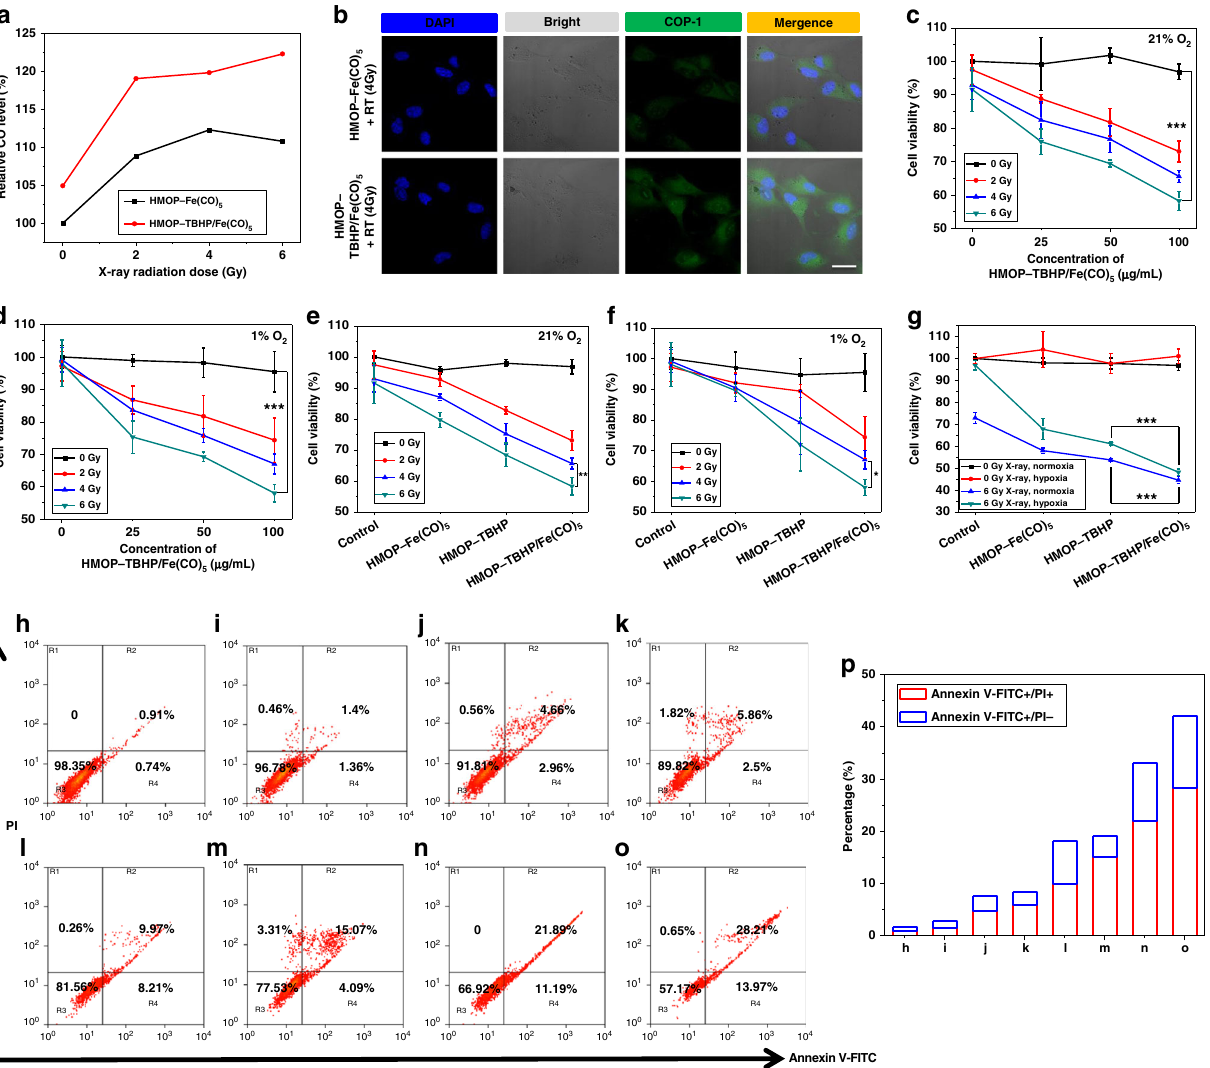
Fig. 7 In vitro evaluation of synergistic RDT/gas therapy. a Quantitative evaluation of CO generation in normoxic (21% O 2 ) U87MG cells after incubation with HMOP-Fe(CO) 5 or HMOP-TBHP/Fe(CO) 5 upon varied doses (0, 2, 4, and 6 Gy) of X-ray irradiation. The intracellular CO was monitored using a fl uorogenic COP-1 probe. b Confocal fl uorescence imaging of normoxic (21% O 2 ) U87MG cells after incubation with HMOP-Fe(CO) 5 or HMOP-TBHP/Fe (CO) 5 upon 4 Gy of X-ray irradiation. Scale bar: 50 µ m. c , d Cell viabilities (by MTT assay) of U87MG cells subjected to varied doses (0, 2, 4, and 6 Gy) of X-ray irradiation with or without different concentrations of (0, 25, 50, 100 µ g mL − 1 ) HMOP-TBHP/FeCO under normoxic (21% O 2 ) condition ( c ) and hypoxic (1% O 2 ) condition ( d ), respectively. e , f Cell viabilities (by MTT assay) of normoxic (21% O 2 ) U87MG cells ( e ) and hypoxic (1% O 2 ) U87MG cells ( f ) after treated with HMOP-Fe(CO) 5 , HMOP-TBHP or HMOP-TBHP/Fe(CO) 5 plus varied doses (0, 2, 4, and 6 Gy) of X-ray irradiation for 24h. g Cell viabilities (by MTT assay) of normoxic and hypoxic U87MG cells after treated with HMOP-Fe(CO) 5 , HMOP-TBHP, or HMOP-TBHP/Fe(CO) 5 plus 6 Gy of X-ray irradiation for 48 h. n = 4, mean ± s.d., * P < 0.05, ** P < 0.01, *** P < 0.001, Student ’ s two-tailed t -test. h – o Flow cytometry analysis of the apoptosis of normoxic (21% O 2 ) U87MG cells subjected to different treatments: control ( h ), HMOP-Fe(CO) 5 ( i ), HMOP-TBHP ( j ), HMOP-TBHP/Fe(CO) 5 ( k ), RT (6 Gy) ( l ), HMOP-Fe(CO) 5 + RT (6 Gy) ( m ), HMOP-TBHP + RT (6 Gy) ( n ), HMOP-TBHP/Fe(CO) 5 + RT (6 Gy) ( o ). p Quantitative analysis of the corresponding cell apoptosis (Annexin V-FITC + /PI − )/necrosis (Annexin V-FITC + /PI + ) percentages based on h –